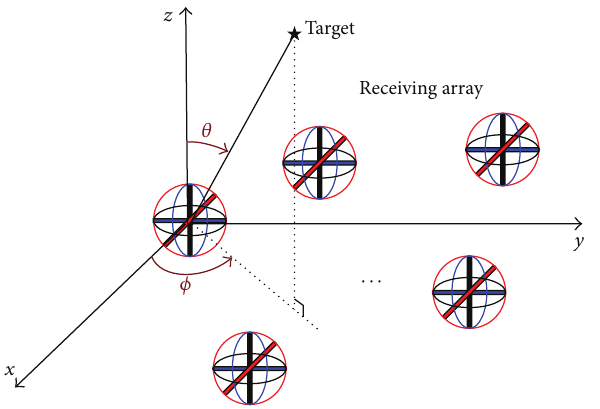
Figure 1: Monostatic MIMO radar with arbitrarily spaced electro- magnetic vector received sensors at unknown locations.